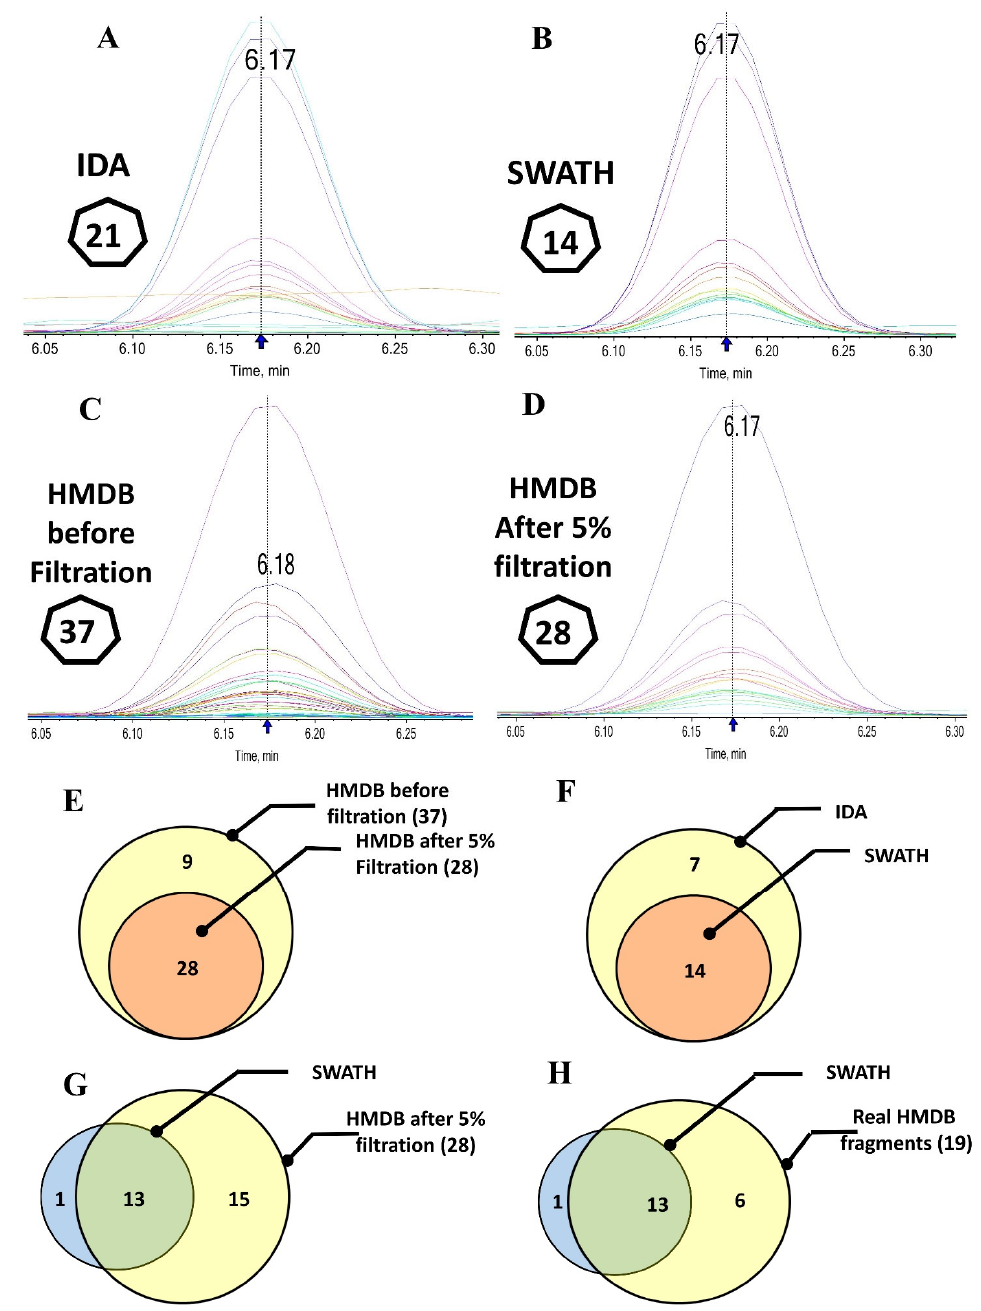
Figure 5. Comparison and overlapping between tryptophan fragmentation pattern spectra of SWATH with IDA and HMDB (each color spectra represent different fragments). It shows IDA ( A ) and SWATH fragments ( B ), while ( C , D ) clarify fragments present in the HMDB before and after filtration. ( E – H ) represents their